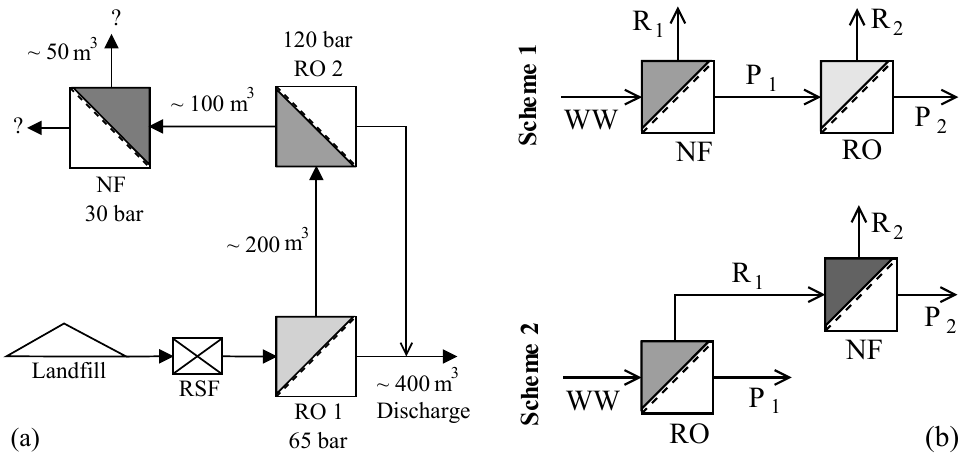
Figure 1. ( a ) Treatment scheme at landfill site (based on IAG [17] and Rautenbach et al. [19]) (RSF—rapid sand filtration); ( b ) Integration options investigated in this study (WW—wastewater/leachate, R—Retentate, P—Permeate).